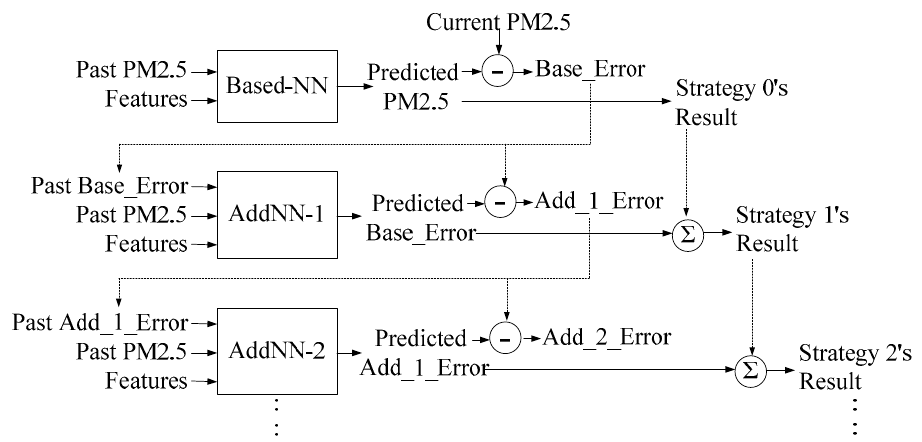
Figure 10. Construction of based-neural network (based-NN), in which each strategy result is the sum of the outputs of the based-NN and add-on neural networks (AddNNs).